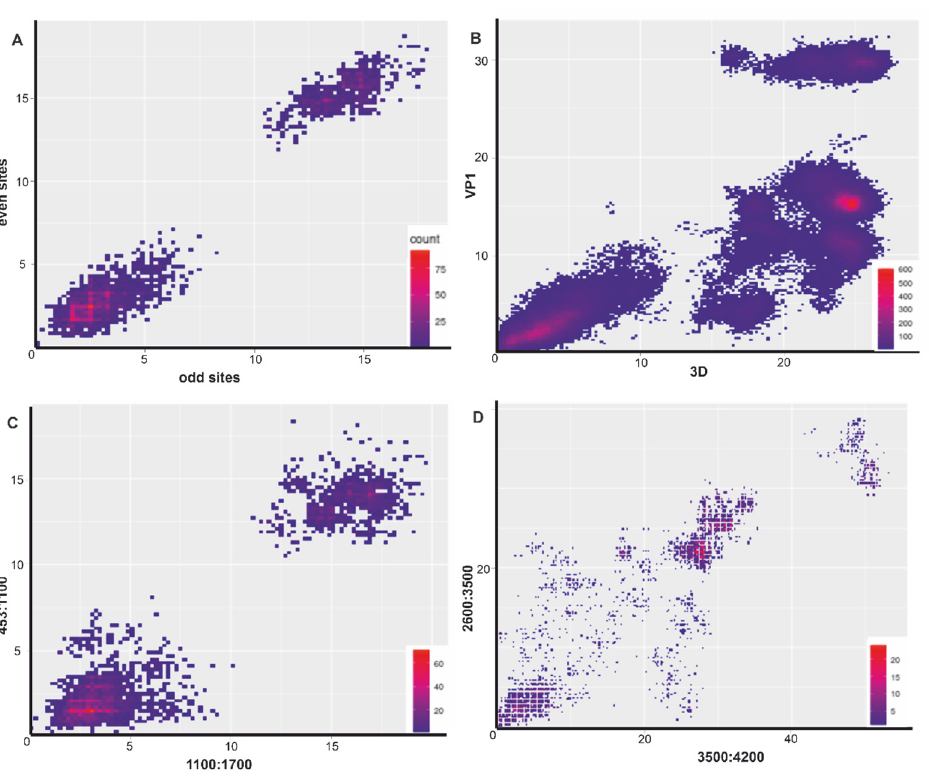
Figure 2. Pairwise nucleotide distance comparison plots (PDCP) indicate recombination between two genetic regions. Each dot corresponds to a pair of nucleotide distances between the same pair of genomes in two genomic regions (axis labels): ( A ) PDCP of even and odd sites in the 453–1700 nt